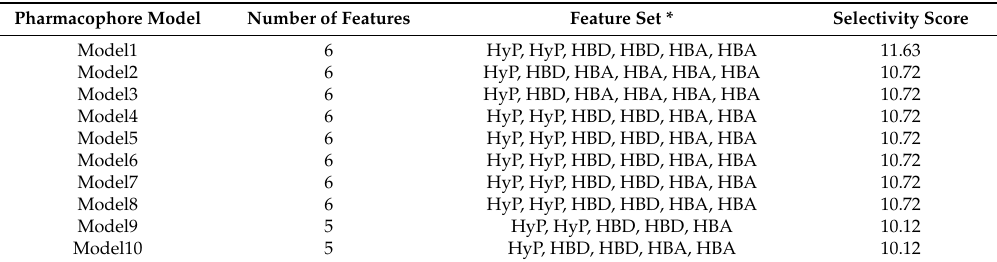
Table 2. Different receptor-ligand based pharmacophores and their features.